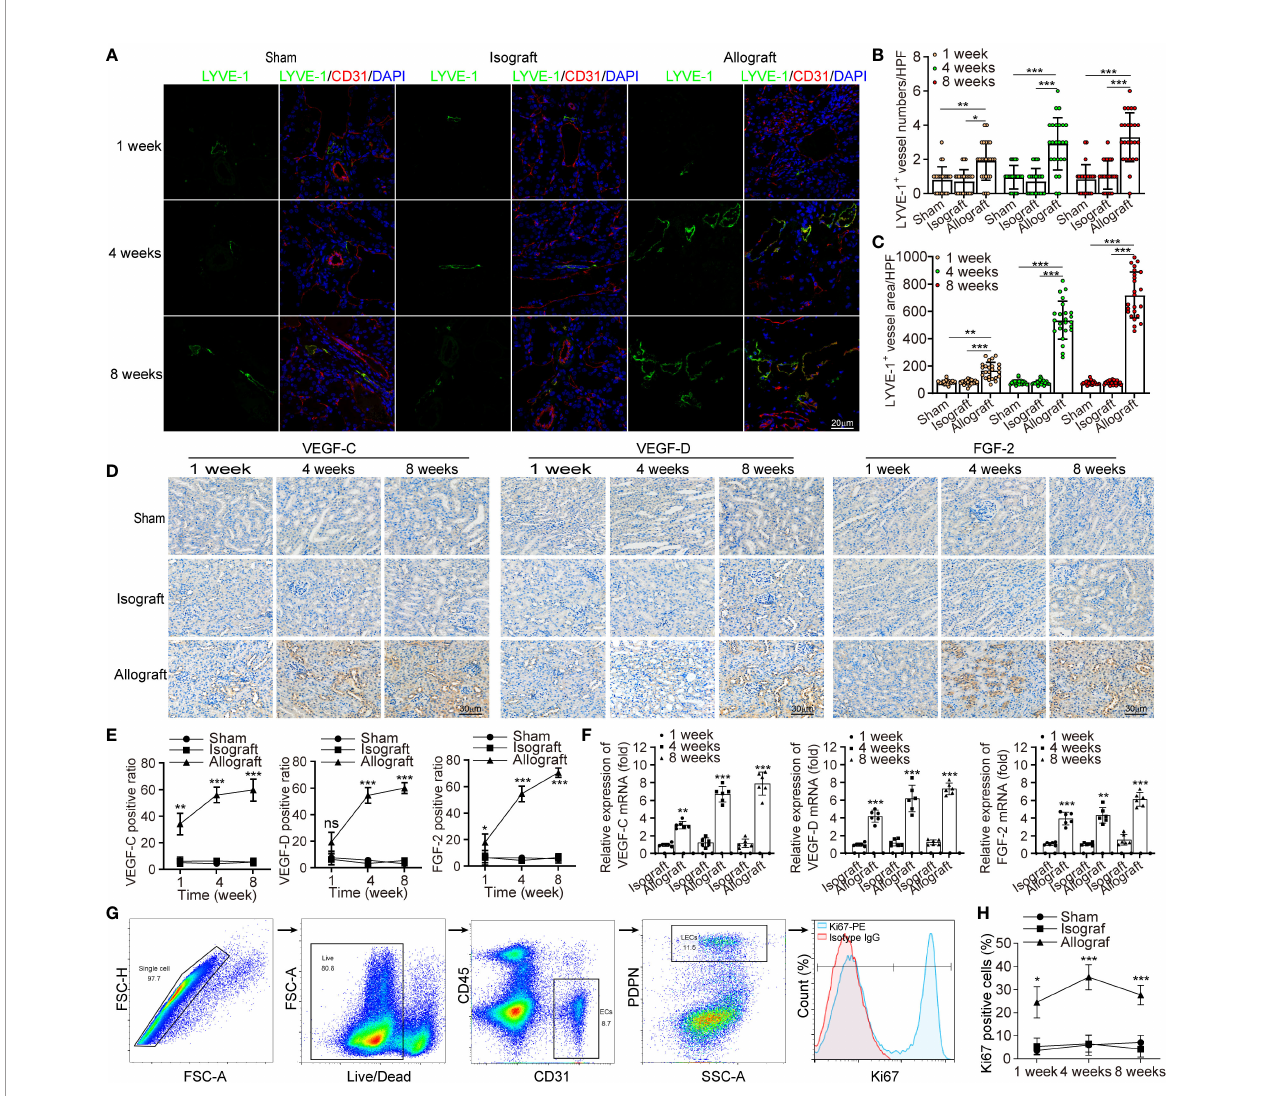
FIGURE 1 | Chronic rejection is associated with lymphangiogenesis in renal allograft. (a) Representative immuno fl uorescence images of LYVE-1, CD31, and DAPI within sham (n=6 mice), isograft (n=6 mice) and allograft (n=6 mice) kidneys at 1, 4 and 8 weeks respectively. (b and c) Numbers and area counting of LYVE-1+ vessels in high-power fi eld (HPF) at 1, 4 and 8 weeks respectively. (d) Immunohistochemistry of VEGF-C, VEGF-D and FGF-2 expression within sham, isograft and allograft kidneys at 1, 4 and 8 weeks respectively. (e) Positive ratio of VEGF-C, VEGF-D and FGF-2 within sham, isograft and allograft kidneys at 1, 4 and 8 weeks respectively. (f) Relative mRNA expression of VEGF-C, VEGF-D and FGF-2 by qRT-PCR within isograft and allograft kidneys at 1, 4 and 8 weeks respectively, using sham as a reference. (g) Live single CD45- PDPN+ CD31+ LECs isolating from renal allograft by gating technology via fl ow cytometry, and the population of Ki67+ cells. (h) The ratio of Ki67+ cells in PDPN+CD31+ LECs within sham, isograft and allograft kidneys at 1, 4 and 8 weeks respectively. *P < 0.05, **P < 0.01, ***P < 0.001. Values are mean ±